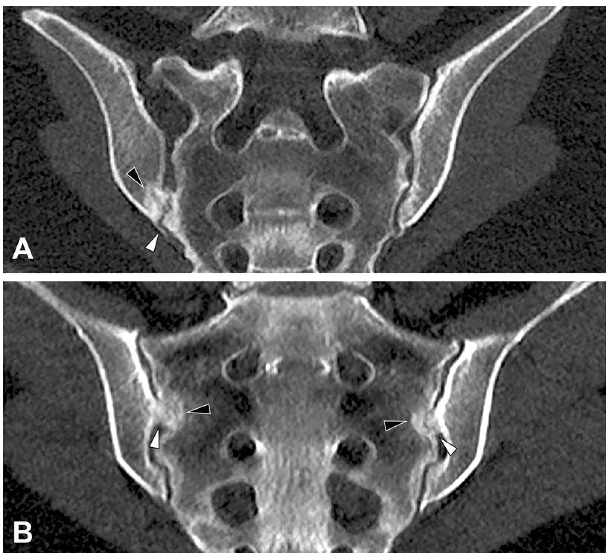
Figure 4. Imaging examples. (A) Female patient with bilateral accessory joints, paracoronal reconstruction. Note the accessory joint facet (white arrowhead) with associated periarticular sclerosis (black arrowhead). (B) Female patient with bilateral iliosacral complex, paracoronal reconstruction. Note the convex ilium notches (white arrowheads), again with associated periarticular sclerosis (black arrowheads).